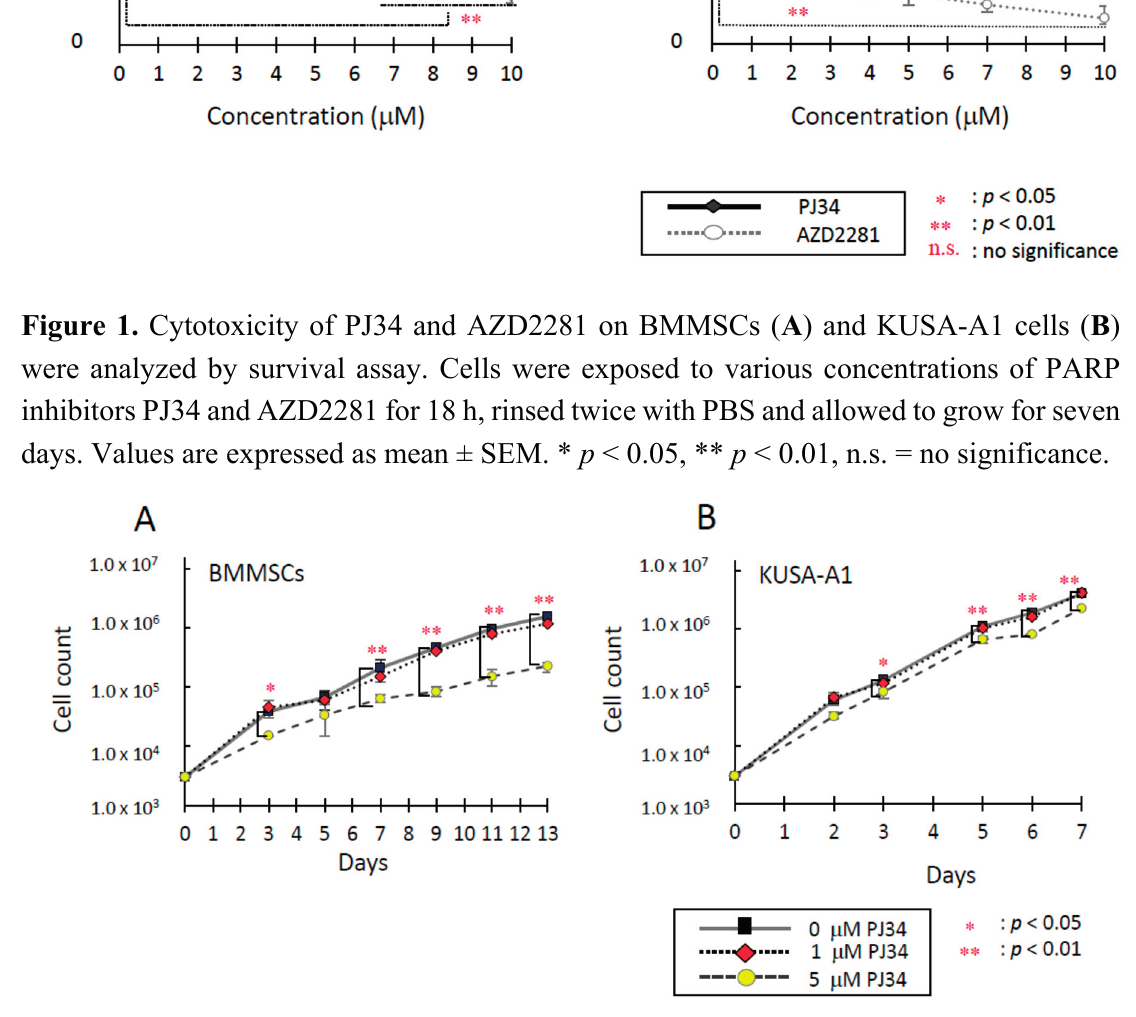
Figure 2. Effects of PJ34 on cell proliferation of BMMSCs ( A ) and KUSA-A1 ( B ) by proliferation assay. Values are expressed as mean ± SEM. * p < 0.05, ** p <